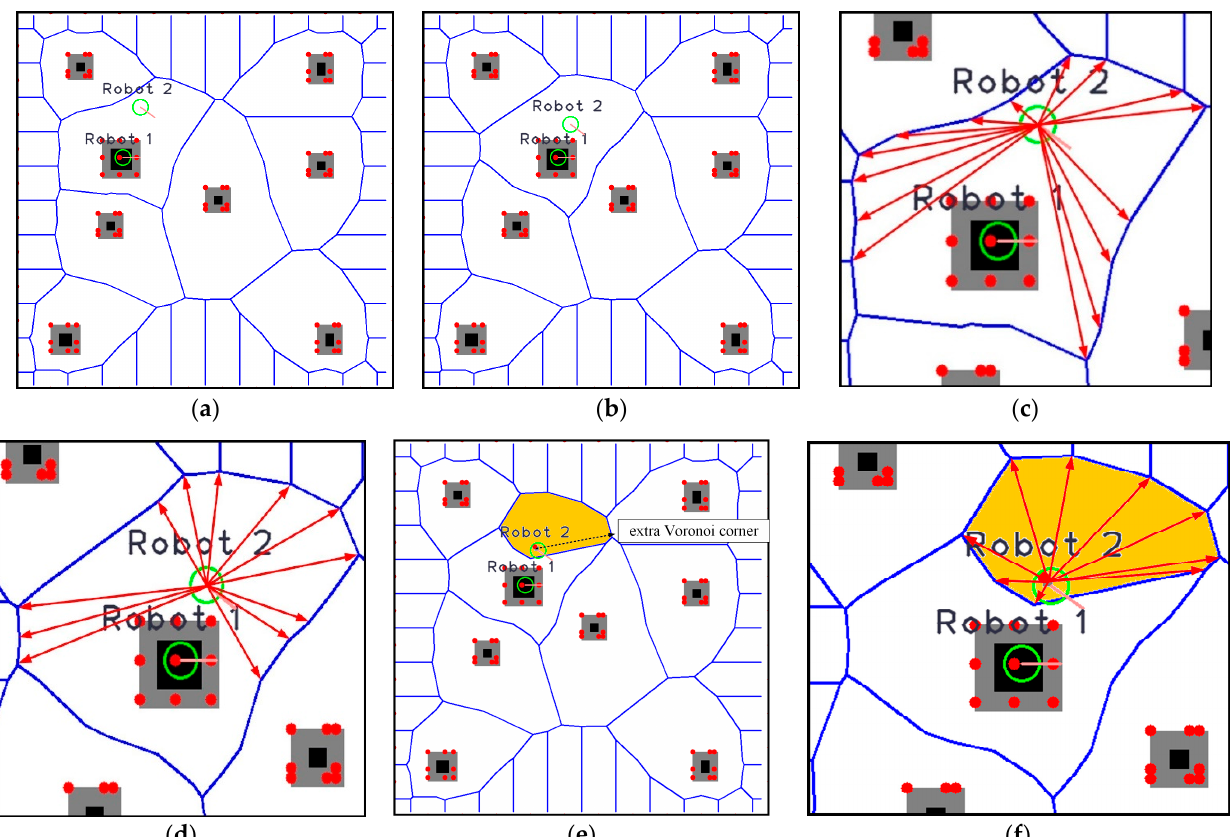
Figure 3. ( a ) The divided map from robot-2’s view point without the assigned extra Voronoi corner at time = t . ( b ) The divided map from robot-2’s view point without the assigned extra Voronoi corner at time = t + 1. ( c ) Local enlargement of ( a ) where the red arrows are the feasible paths; ( d ) local enlargement of ( b ) where the red arrows are the feasible paths; ( e ) robot-2’s map with the assigned extra Voronoi corner at time = t + 1; and ( f ) local enlargement from ( e ) at time = t + 1, where the yellow region is the extra Voronoi cell.